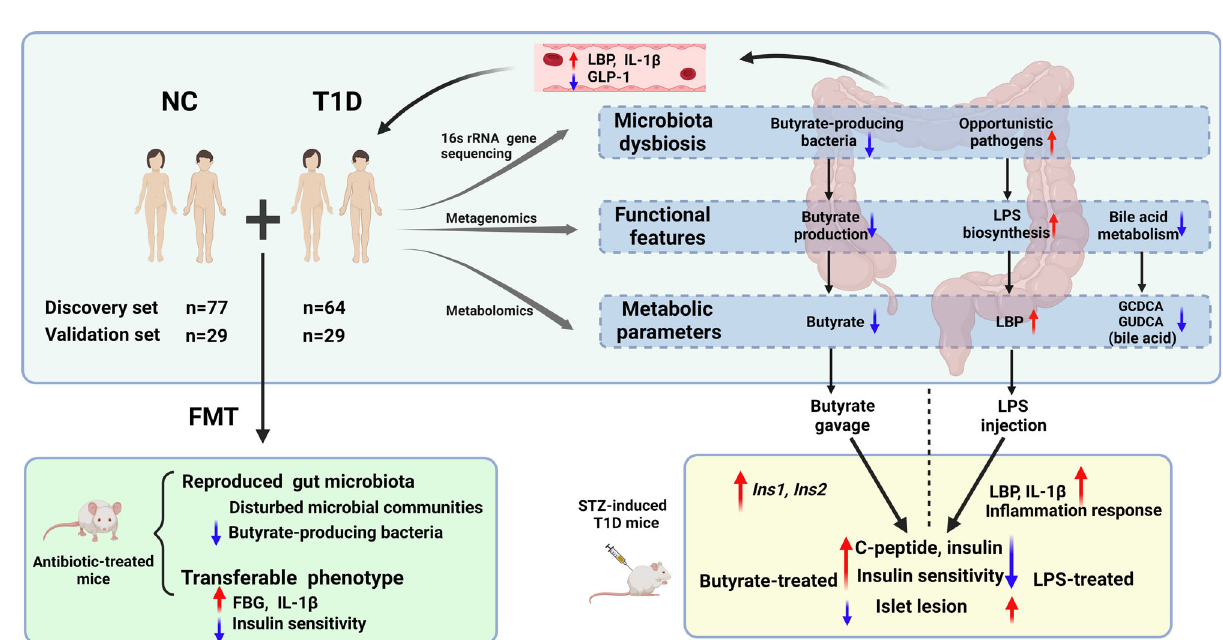
Fig. 6 | Roles of butyrate and LPS in STZ-induced T1D mice. a Fasting blood glucose levels (Model vs Butyrate: 2th week, p =0.036; 4th week, p =0.057; 6th week, p =0.011), b Glucose tolerance test (Model vs Butyrate: 0min, p =0.022; 60min, p =0.046; 120min, p =0.012), c Insulin tolerance test (Model vs Butyrate: 0min, p =0.006;15min, p =0.009;30min, p =0.077,60min, p =0.097),thelevels of d HbA1c(CtrlvsModel, p <0.001;CtrlvsButyrate, p <0.001,ModelvsButyrate, p =0.053) and e C-peptide (Ctrl vs Model, p =0.041; Model vs Butyrate, p =0.026) intheexperimentsinvolvingbutyrategavage.ThesamplesizeisCtrl:n=12,Model: n =11, Butyrate: n =11 asbiologically independent samples. f Fasting blood glucose levels (Model vs LPS: 6th week, p =0.011), g Glucose tolerance test (Model vs LPS: 0min, p =0.029;30min, p =0.053;60min, p <0.001;120min, p =0.035), h Insulin tolerance test (Model vs LPS:0min, p =0.035; 15min, p =0.015; 30min, p =0.044; 120min, p =0.004), the level of i HbA1c (Ctrl vs Model, p <0.001; Ctrl vs LPS, p <0.001)and j C-peptide(CtrlvsModel, p =0.006;CtrlvsLPS, p <0.001;Modelvs LPS, p =0.033) in the experiments involving LPS injection. The sample size is Ctrl: n =10, Model: n =12, LPS: n =12 as biologically independent samples. k Hematoxylin-eosin (H&E) staining and immunohistochemical staining of the pancreas(40-foldand400-foldmagni fi cation,respectively). l Quanti fi cationofthe number of islets using the Image J software (Ctrl vs all other groups, p <0.001;